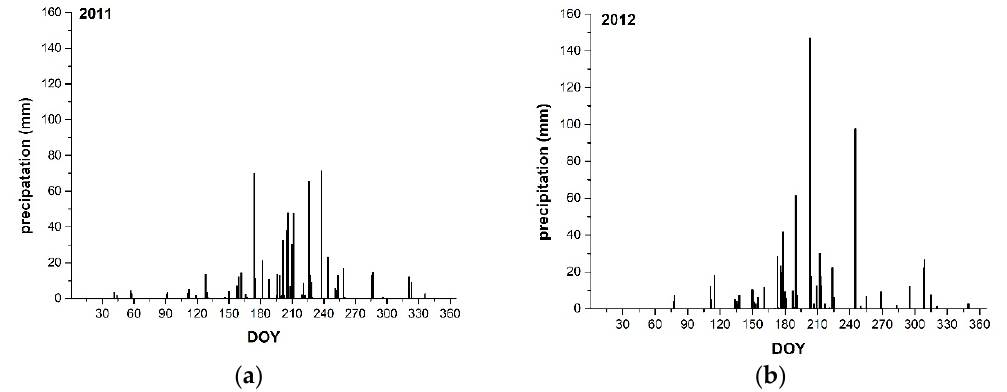
Figure 6. The variation of precipitation during total experimental period (( a ) the variation of precipitation in 2011; ( b ) the variation of precipitation in 2012).